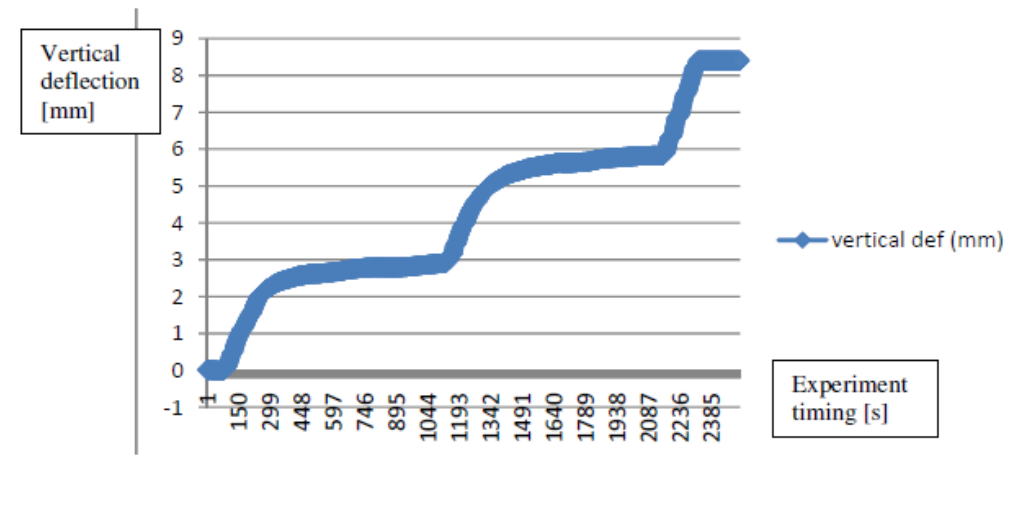
Fig. 10 Vertical deformation in time of